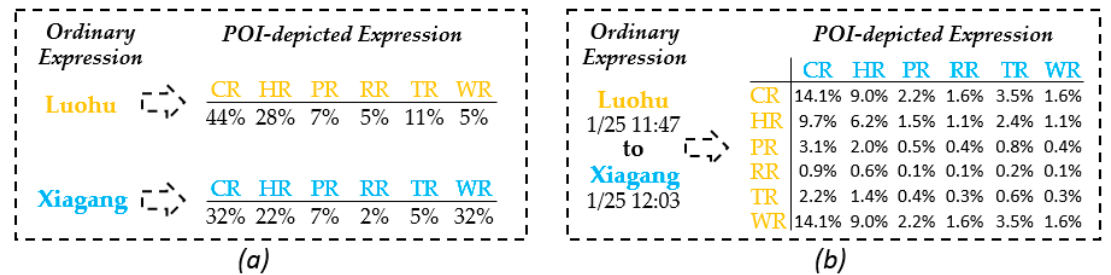
Figure 4. Examples of the points of interest (POI)-depicted metro stations. ( a ) metro station expressed by the POIs feature vector; ( b ) travel between two stations expressed by a 36-variable matrix.